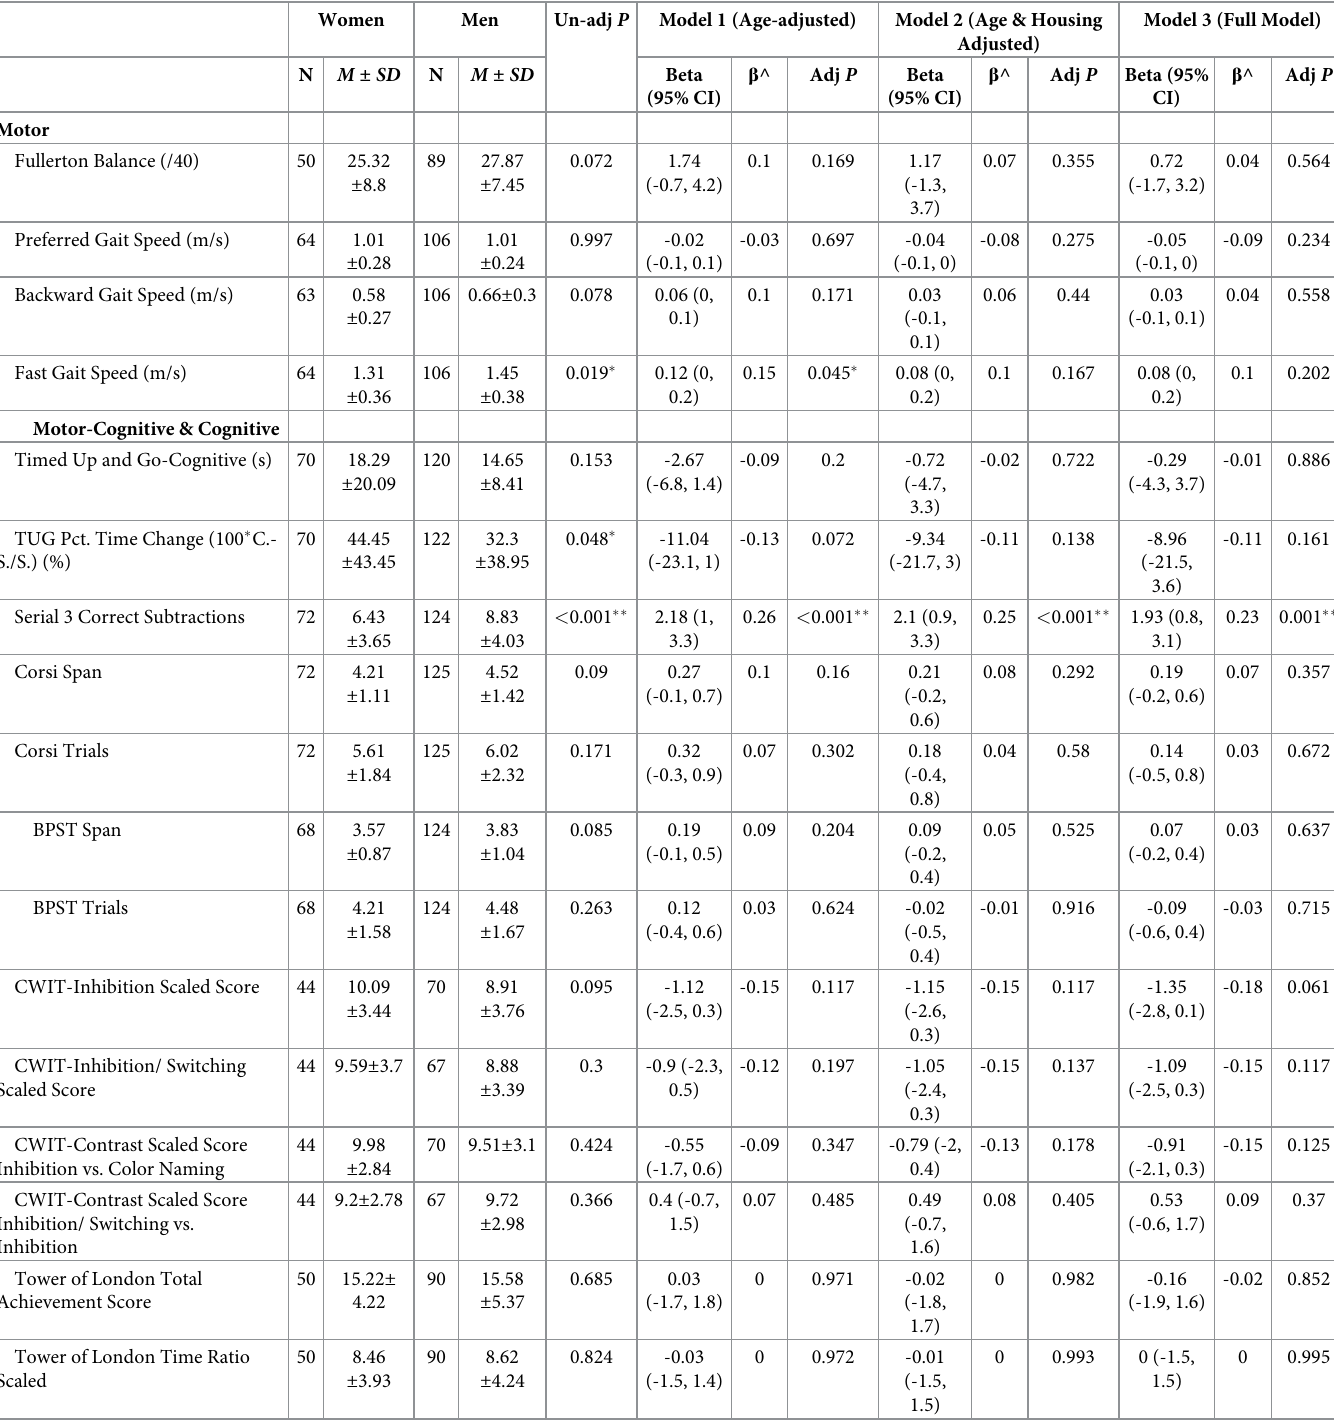
Table 3. Differences between women and men on motor, cognitive, and motor-cognitive